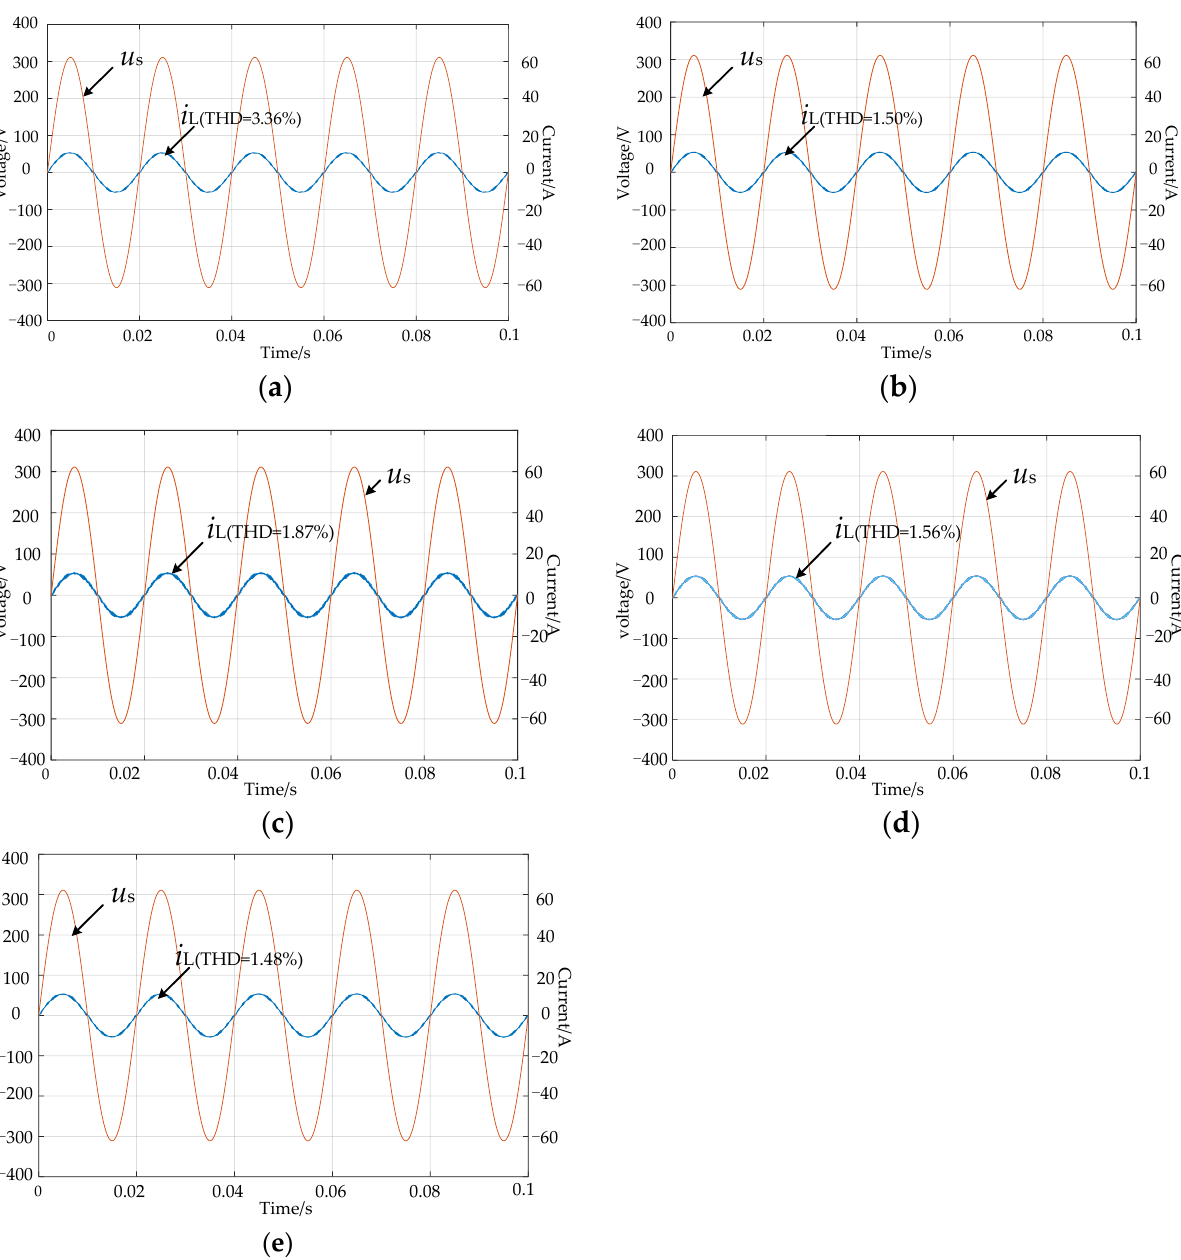
Figure 6. Voltage and current at AC side of rectifier during steady - state operation.